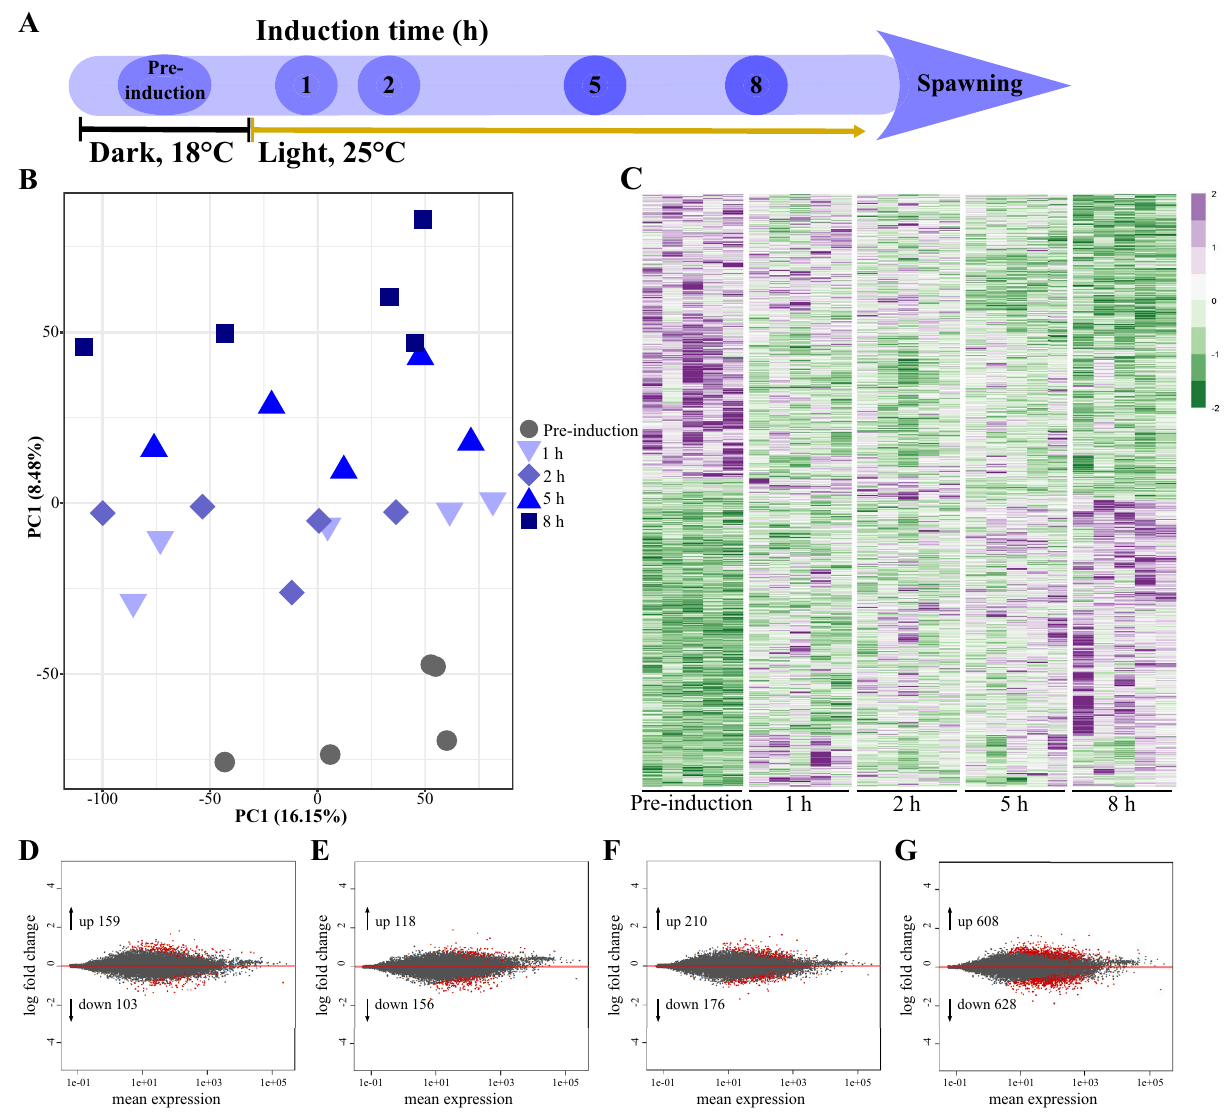
Figure 1. Transcriptome analysis of Nematostella females before and at different time points during spawning induction. ( A ) Schematic presentation of the transcriptome experiment. Induction time refers to time of temperature and light stimulus to successful spawning. Sampling time points are indicated in circles. Dark 18 °C (pre-induction) and light 25 °C (induction) regimes are indicated by black and yellow lines. ( B ) Principal component analysis (PCA) ordination indicates a time-dependent clustering of samples. Color-coded numbers on the right indicate sampling time points (n = 5 individuals per time point). ( C ) Heatmap of differential expressed genes at pre-induction and at the four sampling time points during induction. Rows represent transcripts, columns represent the tested individuals (n = 5). Expression level is indicated by z-score. The full list can be found in Supplementary Table S1. ( D – G ) MA plots showing differentially expressed transcripts at 1 h ( D ), 2 h ( E ), 5 h ( F ), and 8 h ( G ) after induction began, compared to pre-induction. The numbers of up- and down-regulated transcripts are indicated within each plot. Y-axis represents the log 2 fold change, and the X-axis represents mean normalized read counts. Red dots represent differentially expressed